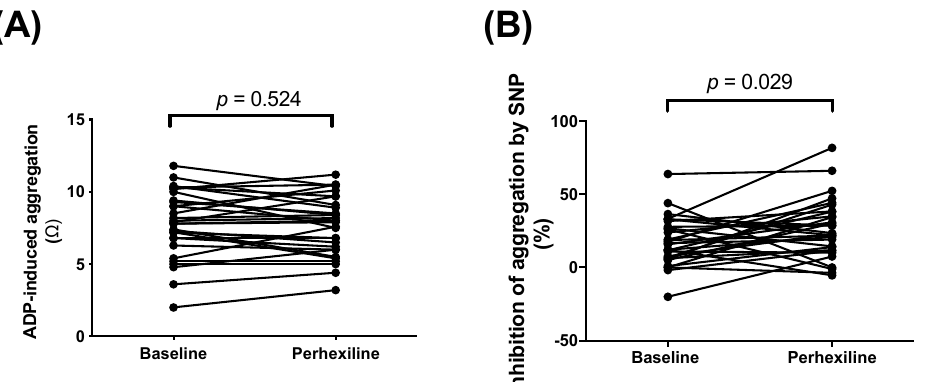
Figure 1. Effects of Px therapy on (ADP-induced platelet aggregation ( A ), and inhibition of ADP- induced platelet aggregation by sodium nitroprusside (SNP) ( B ). To determine whether changes in HOMA-IR values in individual patients also re- lated to increases in NO sensitivity induced by Px, correlations were sought between pro- portional change in HOMA-IR and in SNP response in individual patients. The results, shown in Figure 2, indicated that despite the overall increase in HOMA-IR induced by Px, sensitization to NO tended to be associated with decreases in HOMA-IR. This non-signfi- cant relationship reached significance (r = − 0.40, p = 0.037) if outlying datapoints were re- moved. Furthermore, when these data were analysed categorically, according to whether or not there was any increase in sensitization of NO (Figure 2 inset), increases in HOMA- IR were substantially greater ( p = 0.002) in patients without any sensitization to NO.